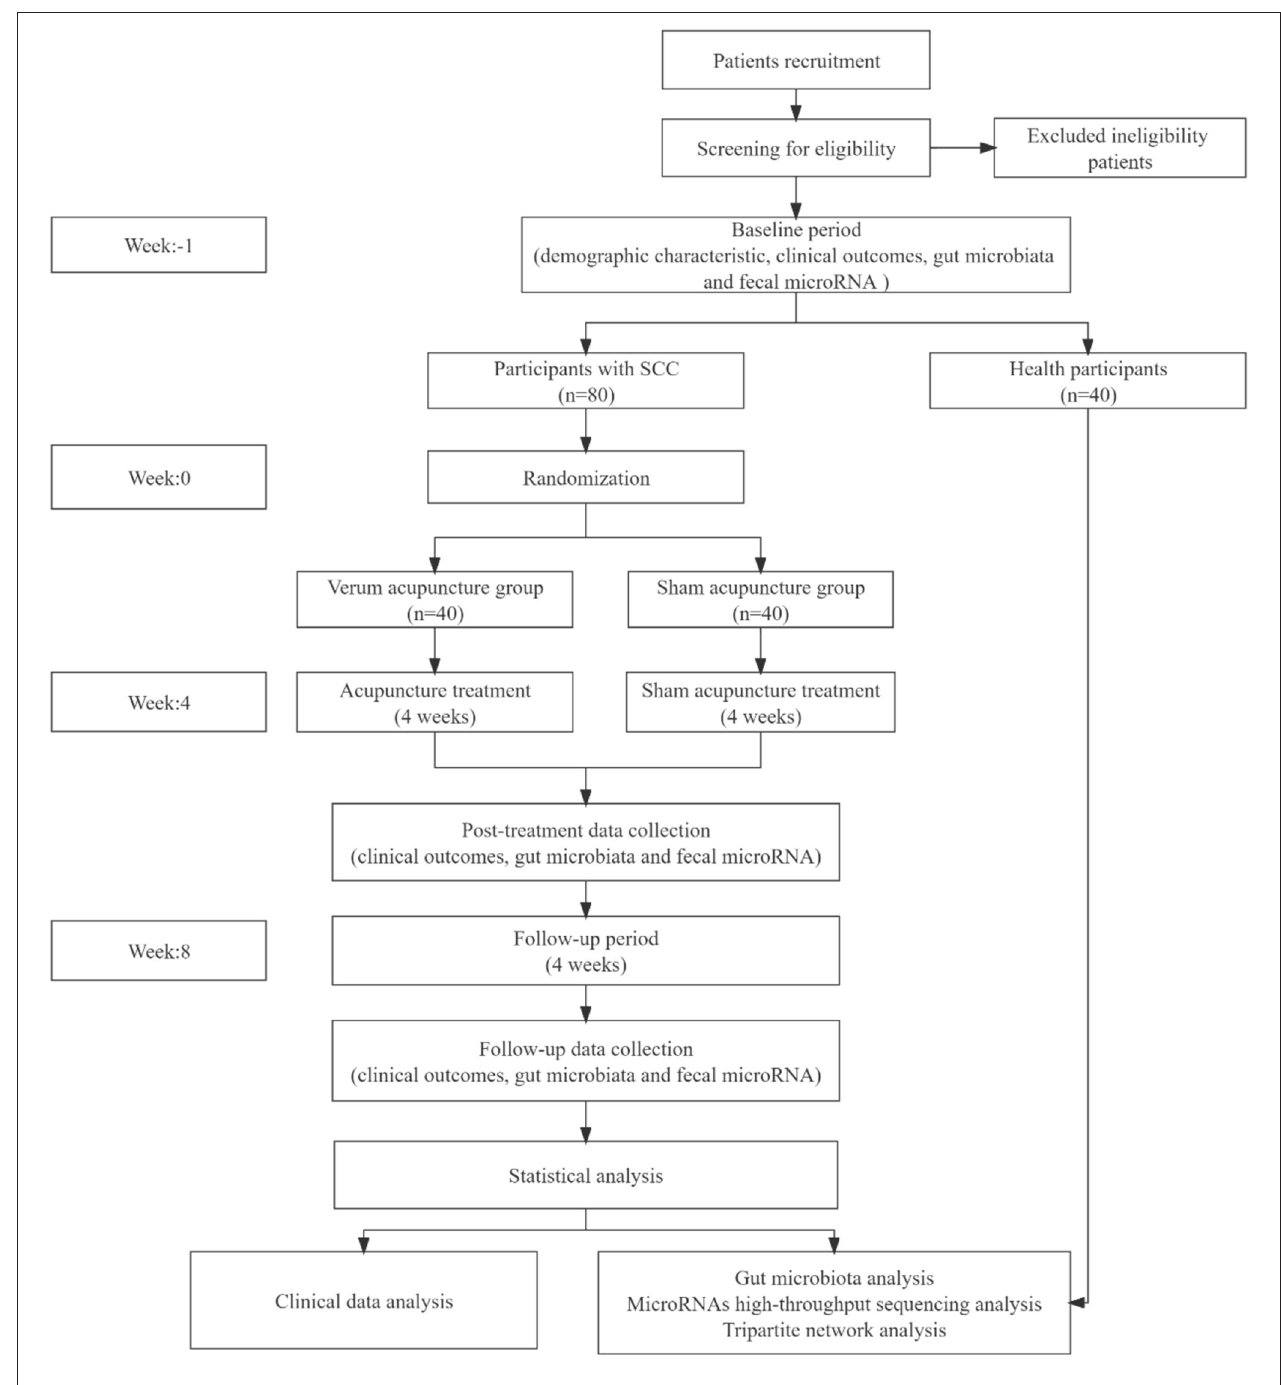
FIGURE 1 | Flowchart of the trial design. 3. Two or fewer CSBMs per week, exertion in defecation, and lumpy or hard stools (Bristol Stool Form Scale [BSFS] ≤ 3) during the run-in period; 4. No special eating habits and not accompanied by severe anxiety, depression, or other mental disorders (SAS or SDS score < 75);